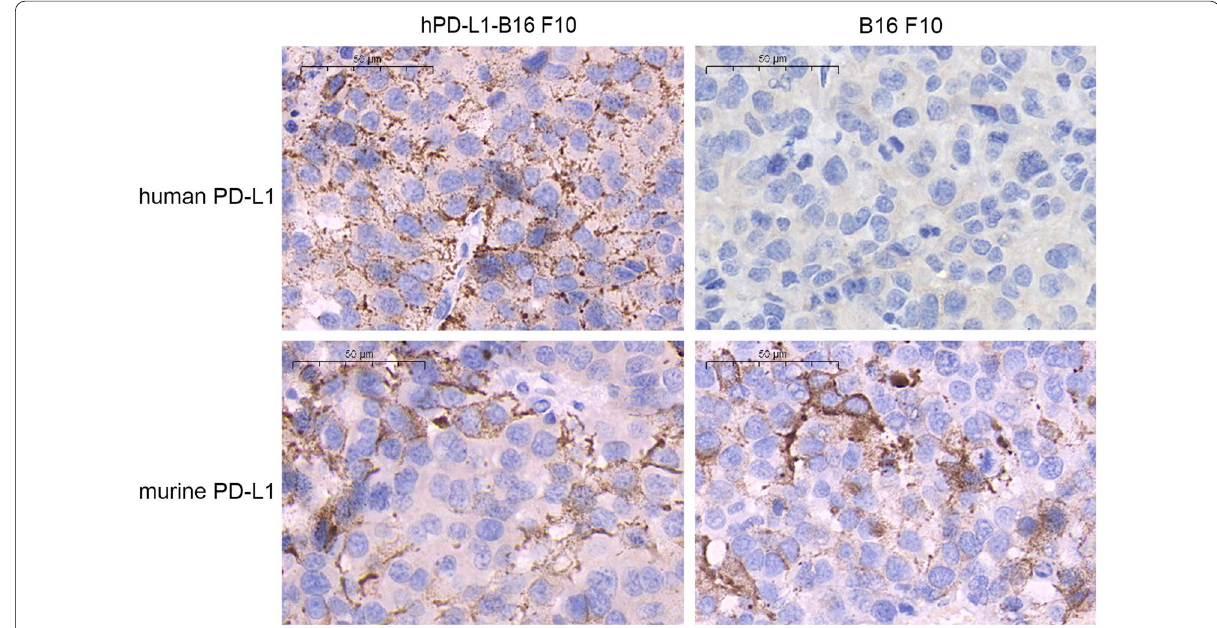
Fig. 6 Representative images of hPD-L1 expression in the hPD-L1-B16F10 tumors (400, Bar